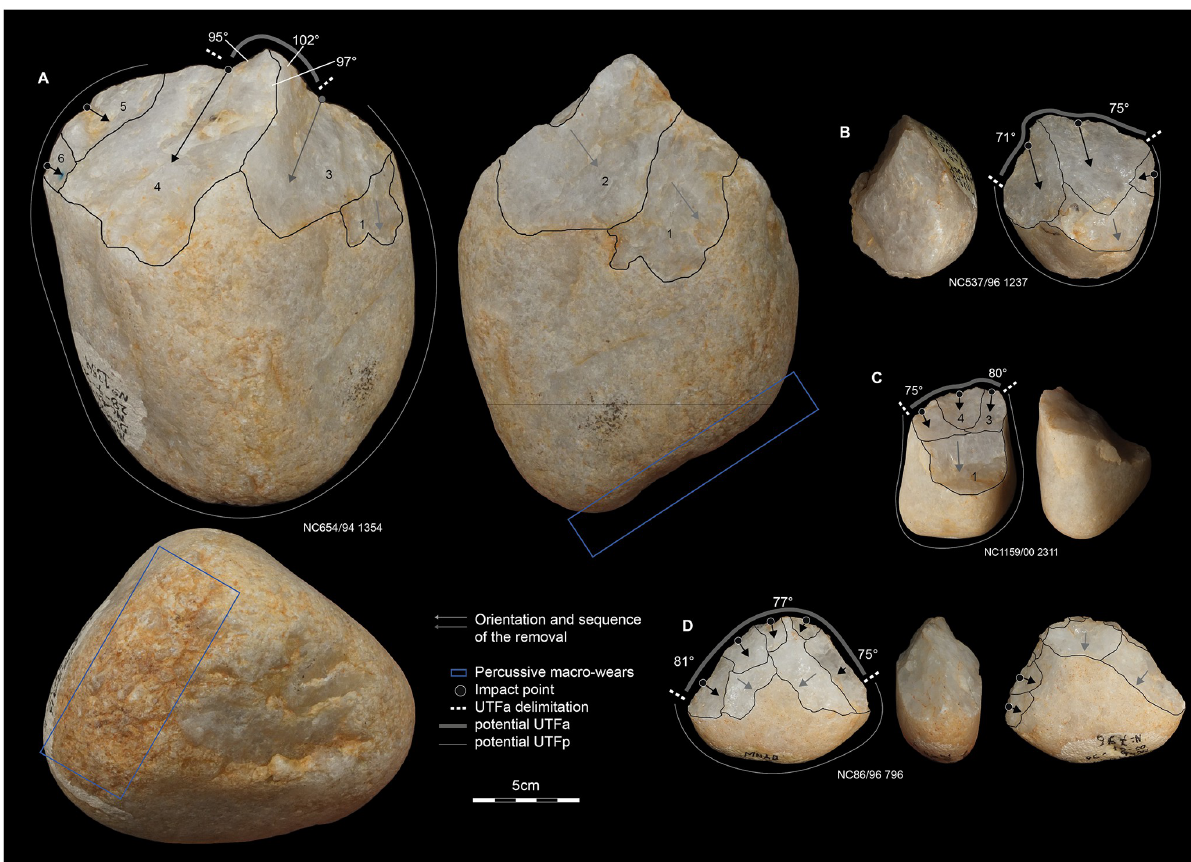
Fig 10. Examples of pebble/cobble tools from Dungo IV. A is a pick on a cobble presenting macro-wear patterns on the proximo-lateral cortical surface. B and C are micro-choppers whereas D is a micro-chopping-tool.